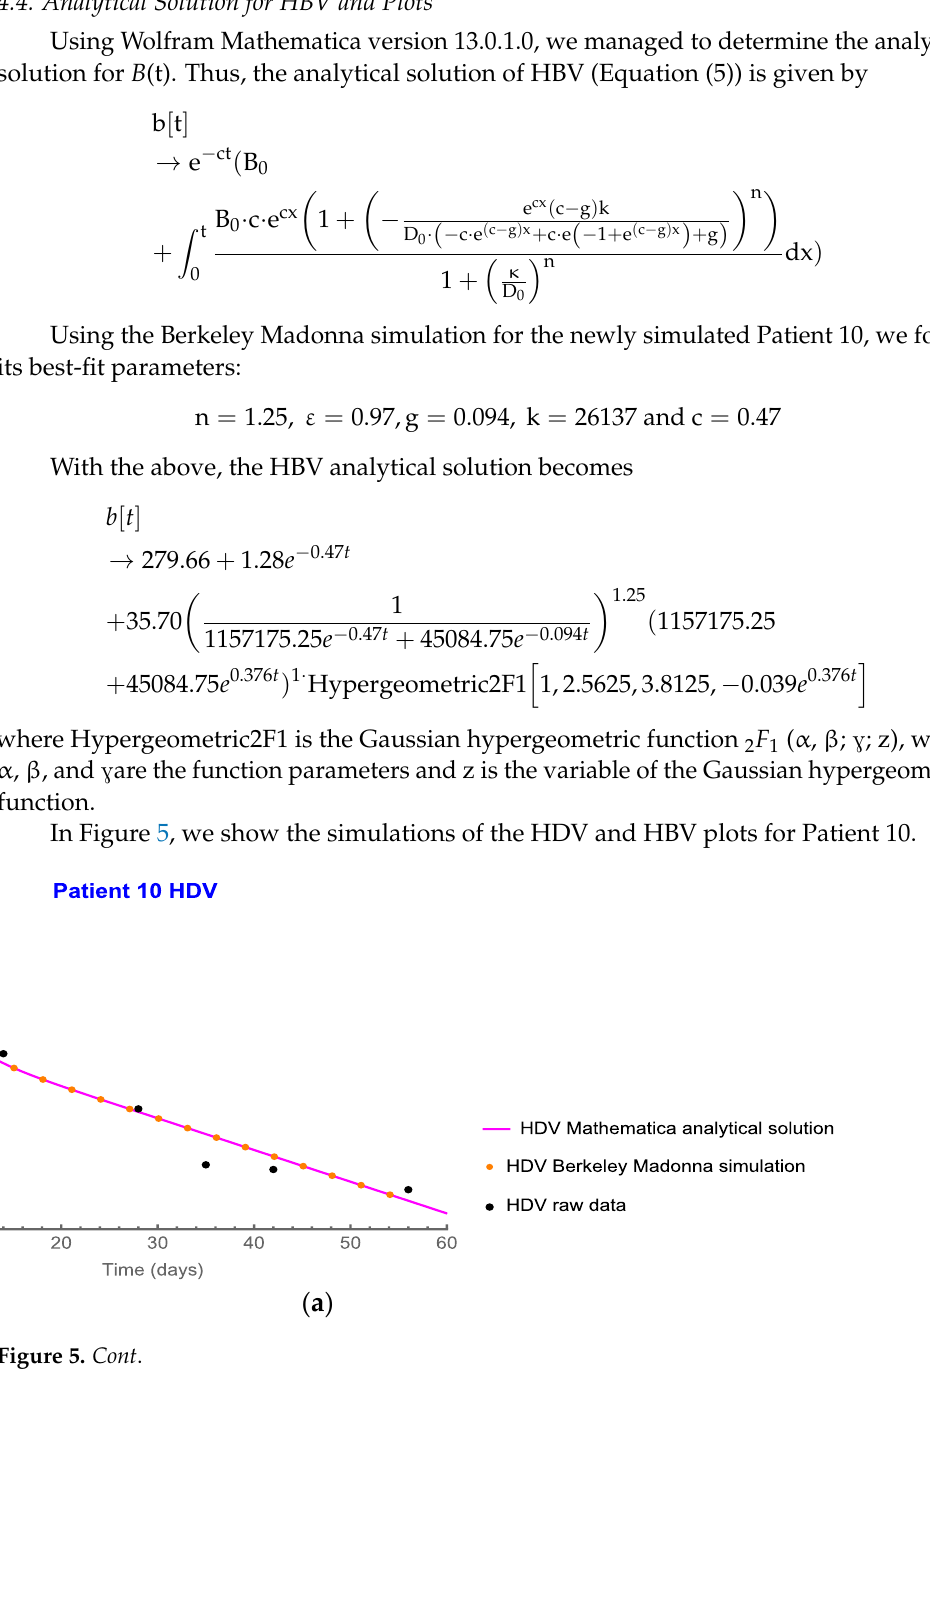
( b ) Figure 5. ( a ) shows the HBV Mathematica analytical solution (i.e., Equation (13) herein), HBV Berke- ley Madonna fit for Patient 10, which was a result of fitting the modified model Equations (1) and (5) with measured data using Berkeley Madonna. ( b ) follows a similar approach as conducted in 5a but for HDV using D.